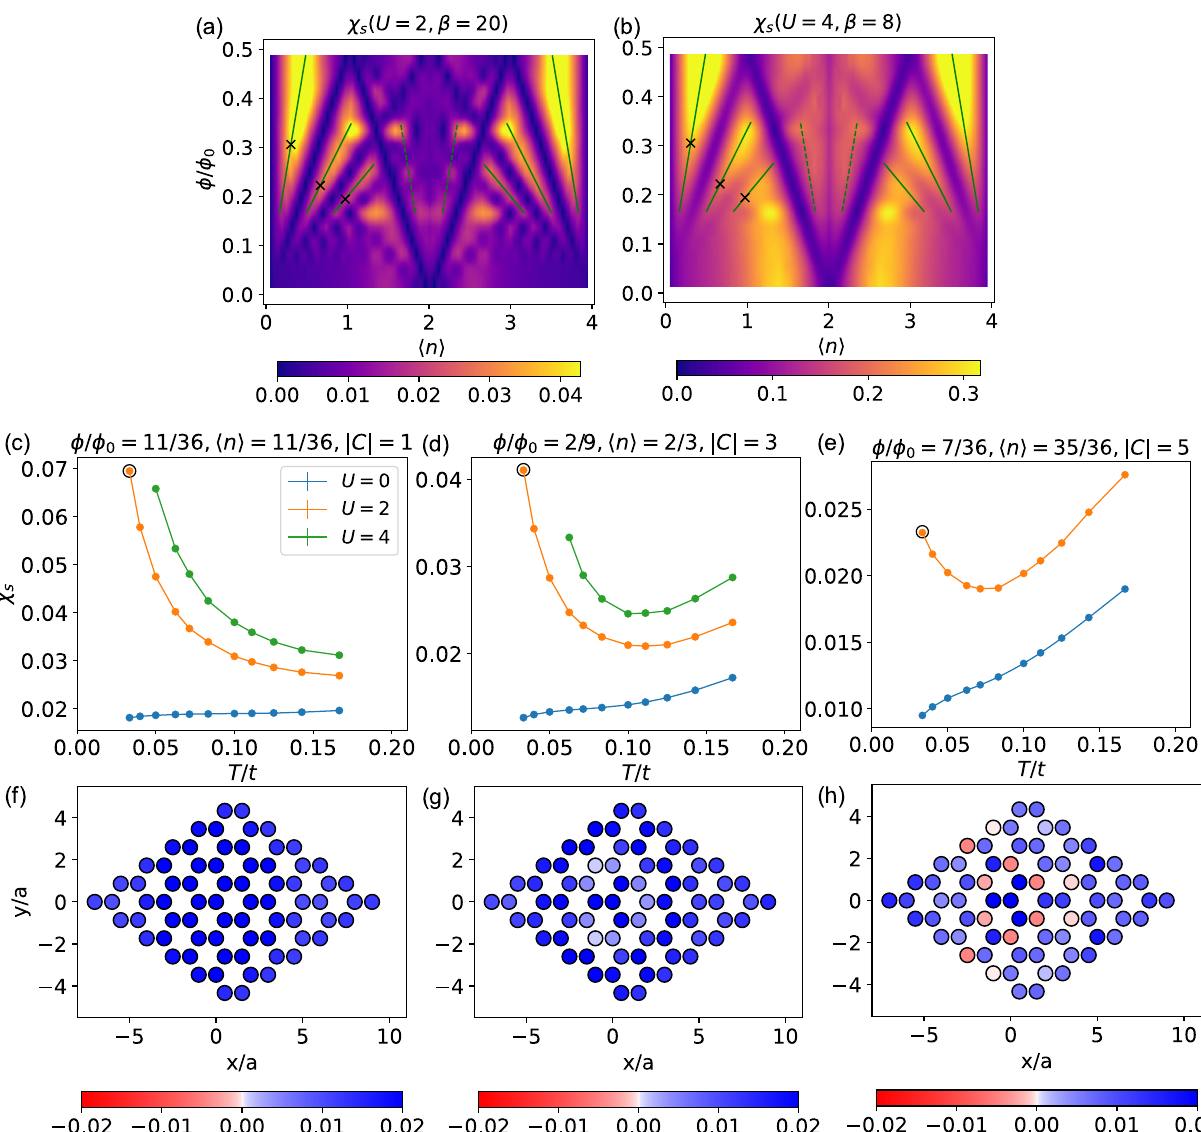
Fig. 4 Spin correlation and ferromagnetic states. The fi rst row shows the spin correlation at ( a ) U / t = 2, β = 20/ t and ( b ) U / t = 4, β = 8/ t , with the green lines depicting the odd integer Chern states aligned with the ridge of the spin correlation. Panels ( c – e ) in the second row show the spin correlation for selected points (marked at each Chern state in panels ( a ) and ( b )) as a function of temperature under different interaction strengths. Panels ( f – h ) in the third row present the real-space zero-frequency spin susceptibility pattern for the circled points in the corresponding second row (at U / t = 2 and the lowest temperature β = 30/ t